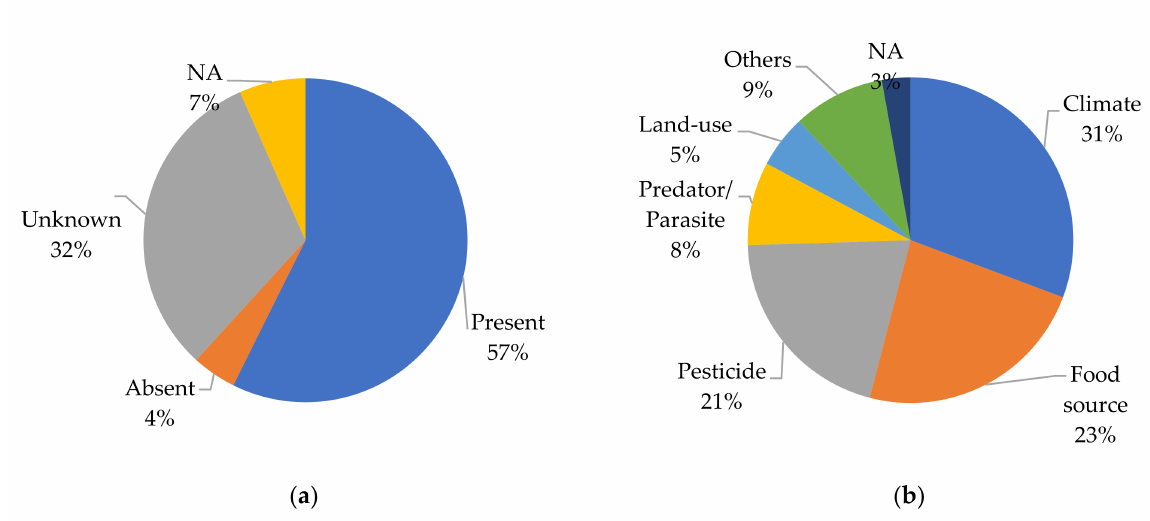
Figure 7. The knowledge of beekeepers on ( a ) the occurrence of bee forager death and ( b ) the factors affecting the